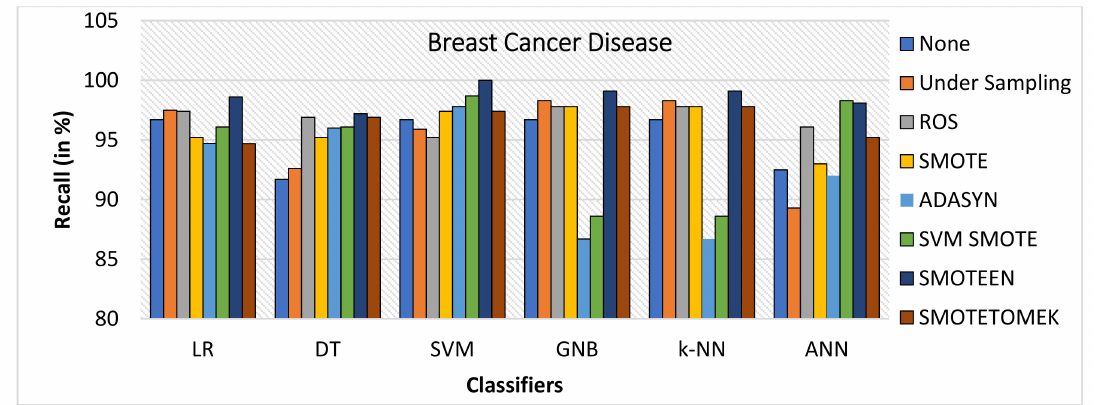
Figure 8. Recall for breast cancer disease dataset of balancing algorithms over six